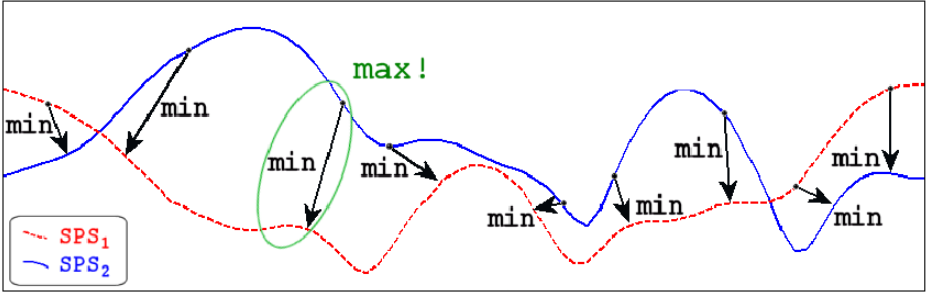
Figure 3. Hausdorff metrics